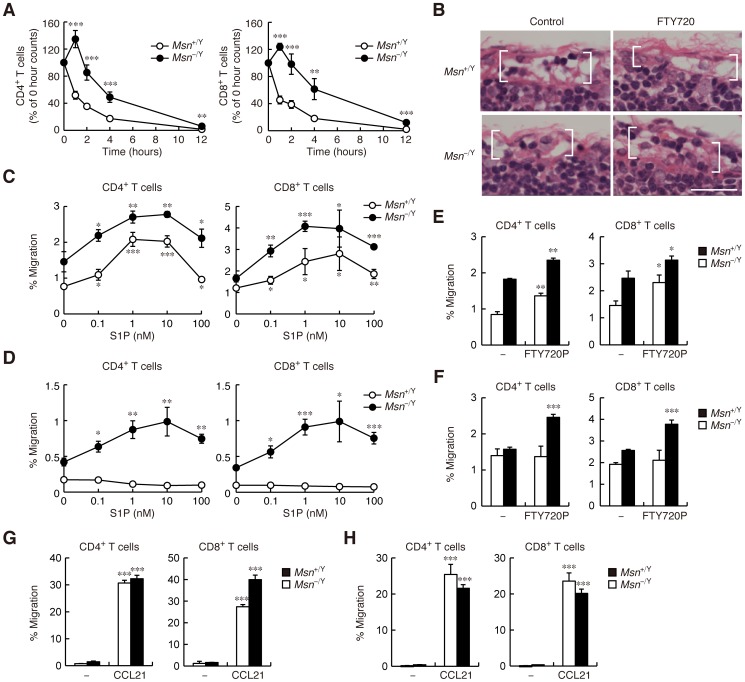
FTY720-induced lymphopenia is delayed in moesin-deficient mice.(A) Peripheral blood lymphocyte count after FTY720 treatment. Msn
+/Y and Msn
−/Y mice were treated with 1 mg/kg FTY720, and peripheral blood samples were collected from mice at the indicated time points. Total leukocytes were counted on a hemocytometer, and the fraction of CD4+ and CD8+ T cell subsets was determined by flow cytometry. Values are expressed as a percentage of the number of CD4+ and CD8+ T cells at each time point compared with zero-hour values. Data are representative of three independent experiments, and are presented as means ± s.e.m. ***, P<0.001; **, P<0.01 versus WT mice (Student's t test). (B) Histological analysis of lymph node sections from mice treated with PBS or FTY720 for 4 h. Inguinal lymph nodes were harvested and prepared for hematoxylin and eosin staining. Subcapsular sinuses are indicated by brackets. Scale bar, 25 µm. (C and D) Chemotactic response to S1P in lymphocytes isolated from mice treated with PBS (C) or FTY720 (D). Msn
+/Y and Msn
−/Y mice were injected with 1 mg/kg FTY720 or PBS; lymph nodes were isolated 12 h later. (E and F) Chemotactic response to FTY720P in lymphocytes isolated from mice treated with PBS (E) or FTY720 (F). (G and H) Chemotactic response to CCL21 in lymphocytes isolated from mice treated with PBS (G) or FTY720 (H). (C–H) Data are representative of three independent experiments and are presented as means ± s.d. of triplicate wells. ***, P<0.001; **, P<0.01; *, P<0.05 versus basal migration (Student's t test).